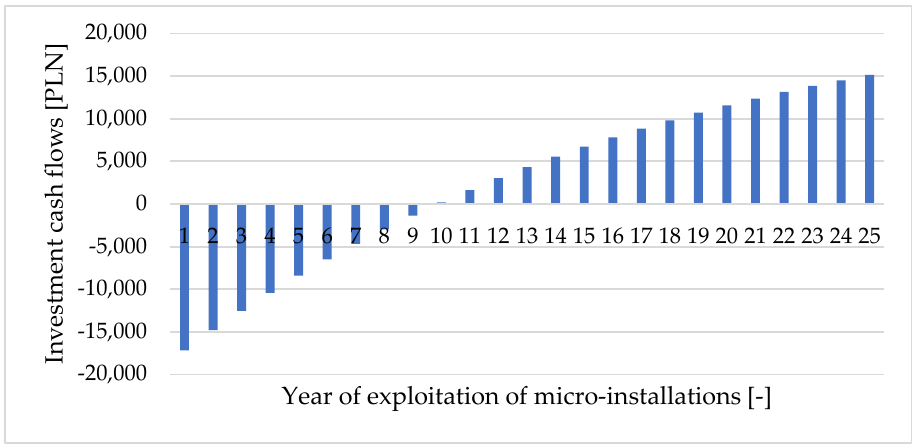
Figure 4. Graph showing the payback period for the capital expenditures incurred in relation to the net-metering system and the 30% self-consumption level.